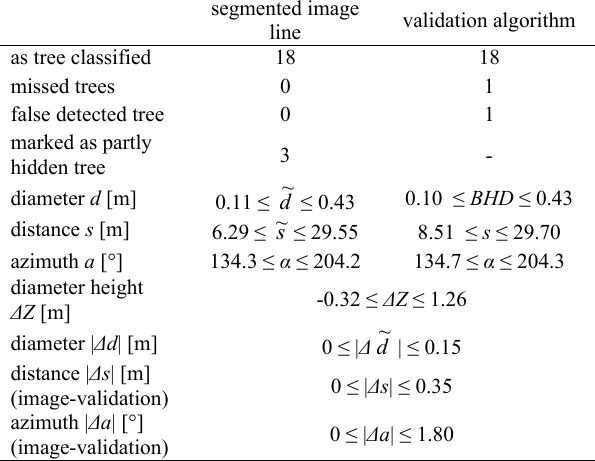
Table 1. Results of the tree detection compared with a 3D cluster search algorithm ('validation